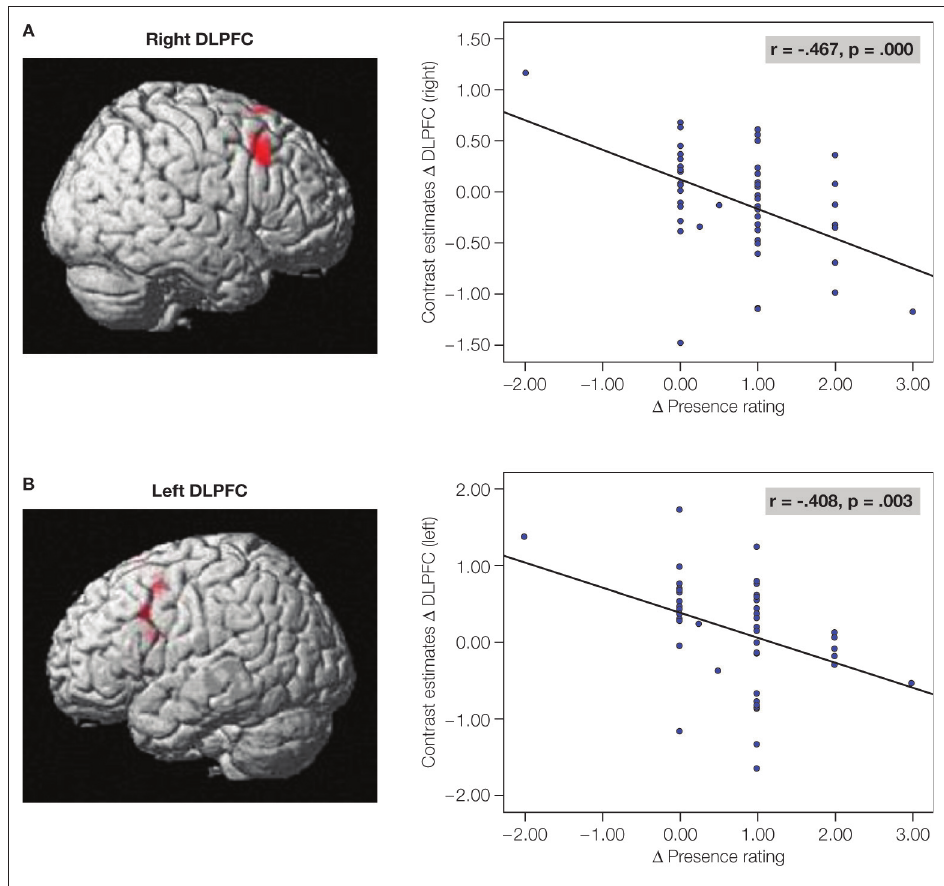
Figure 2 | Correlations between subjective presence experience and the hemodynamic responses in the right-sided (A) and left-sided (B) DLPFC. The correlations were calculated between the mean hemodynamic response in the DLPFC and the subjective presence